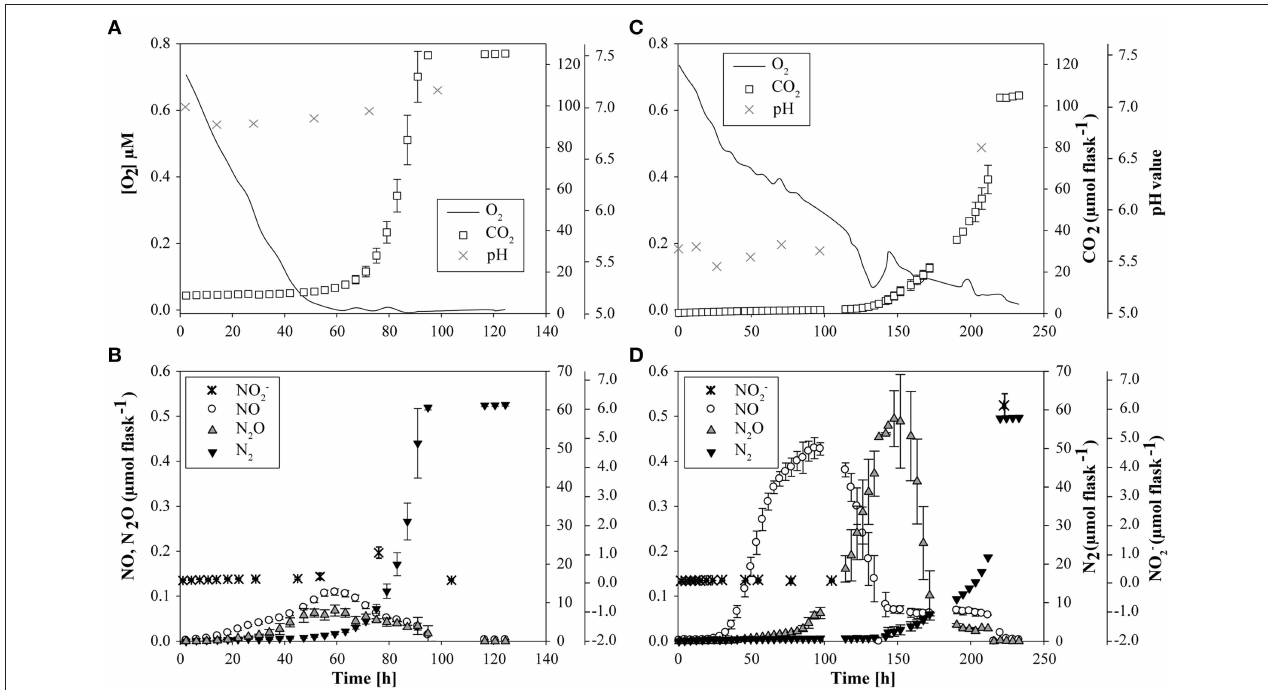
FIGURE 1 | Accumulation of O 2 , CO 2 , NO, N 2 O, N 2 , NO − 2 and changes in pH value in suspensions of cells extracted from a soil from Sweden at initially pH 7.1 (left panels) and at initially pH 5.4 (right panels) during incubation (0–206 h). (A) O 2 , CO 2 concentration and pH value at pH 7.1; (B) NO − 2 , NO, N 2 O and N 2 concentration at pH 7.1; (C) O 2 , CO 2 concentration and pH value at pH 5.4; (D) NO − 2 , NO, N 2 O and N 2 concentration at pH